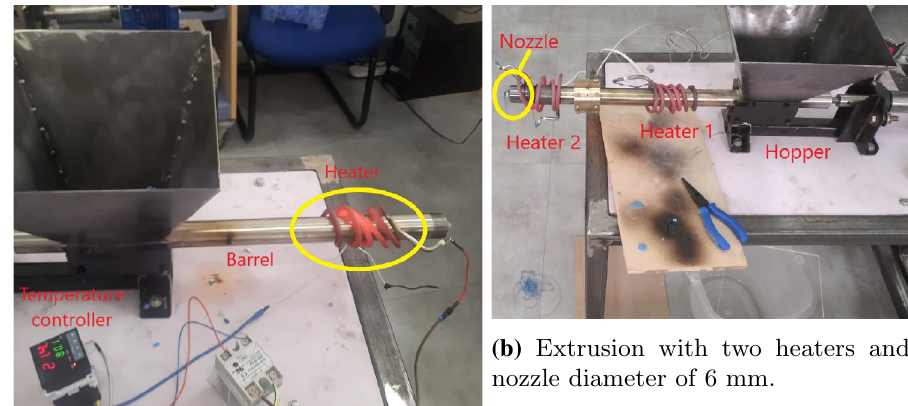
Fig. 15 Extruder with different heater setups